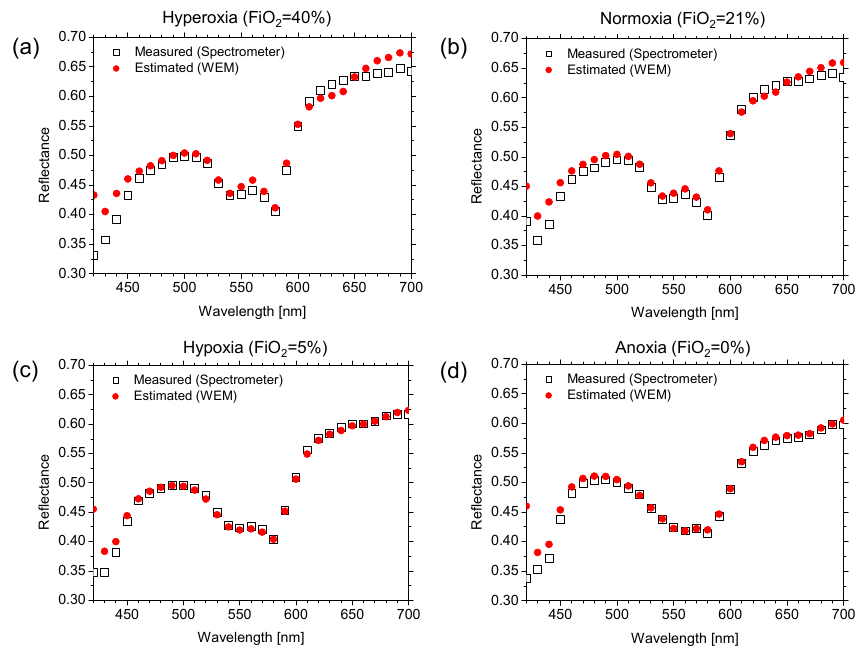
Figure 7. Comparisons of estimated reflectance spectra and reference spectra measured by spectrometer for ( a ) hyperoxia (FiO 2 = 40%), ( b ) normoxia (FiO 2 = 21%), ( c ) hypoxia (FiO 2 = 5%), and ( d ) anoxia (FiO 2 = 0%).